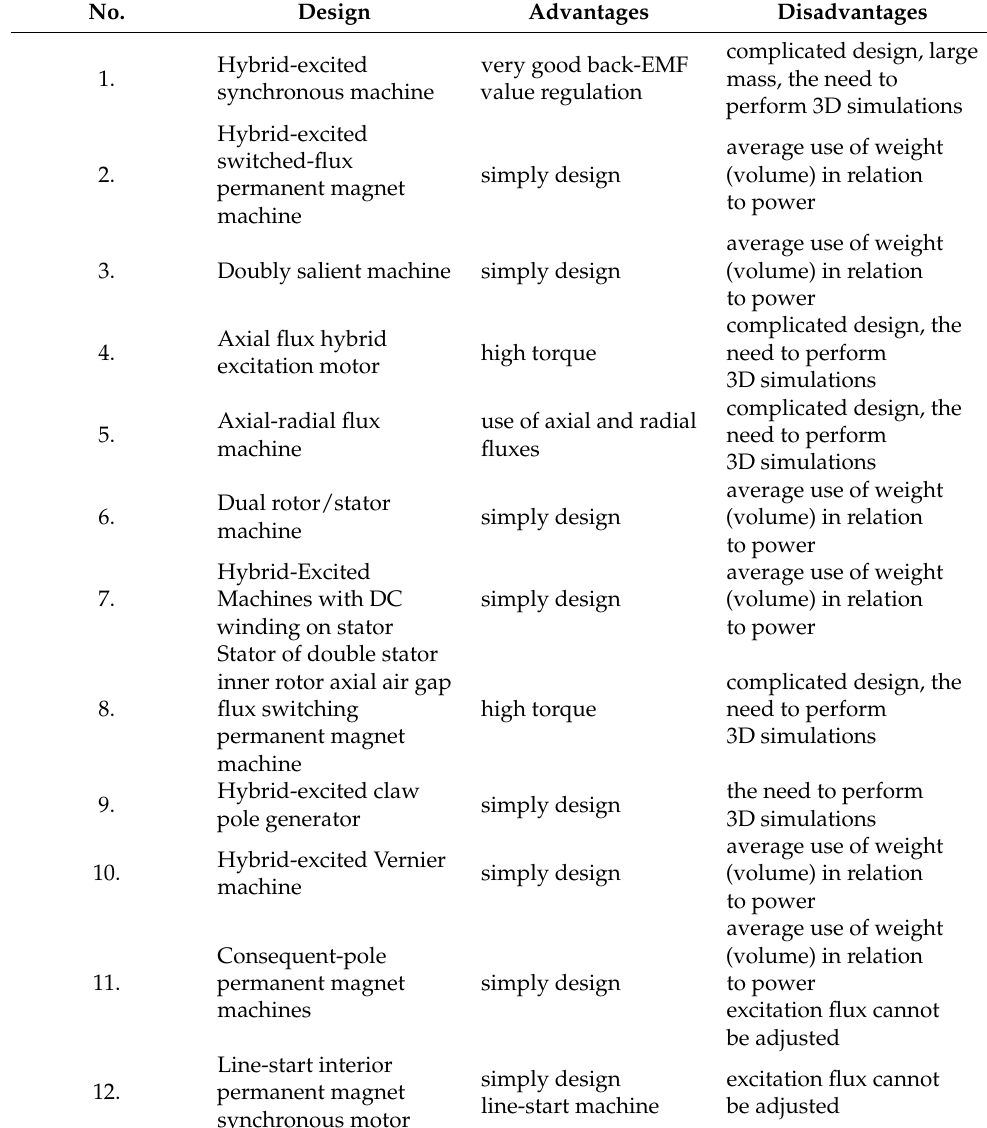
Table 1. Comparison of presented